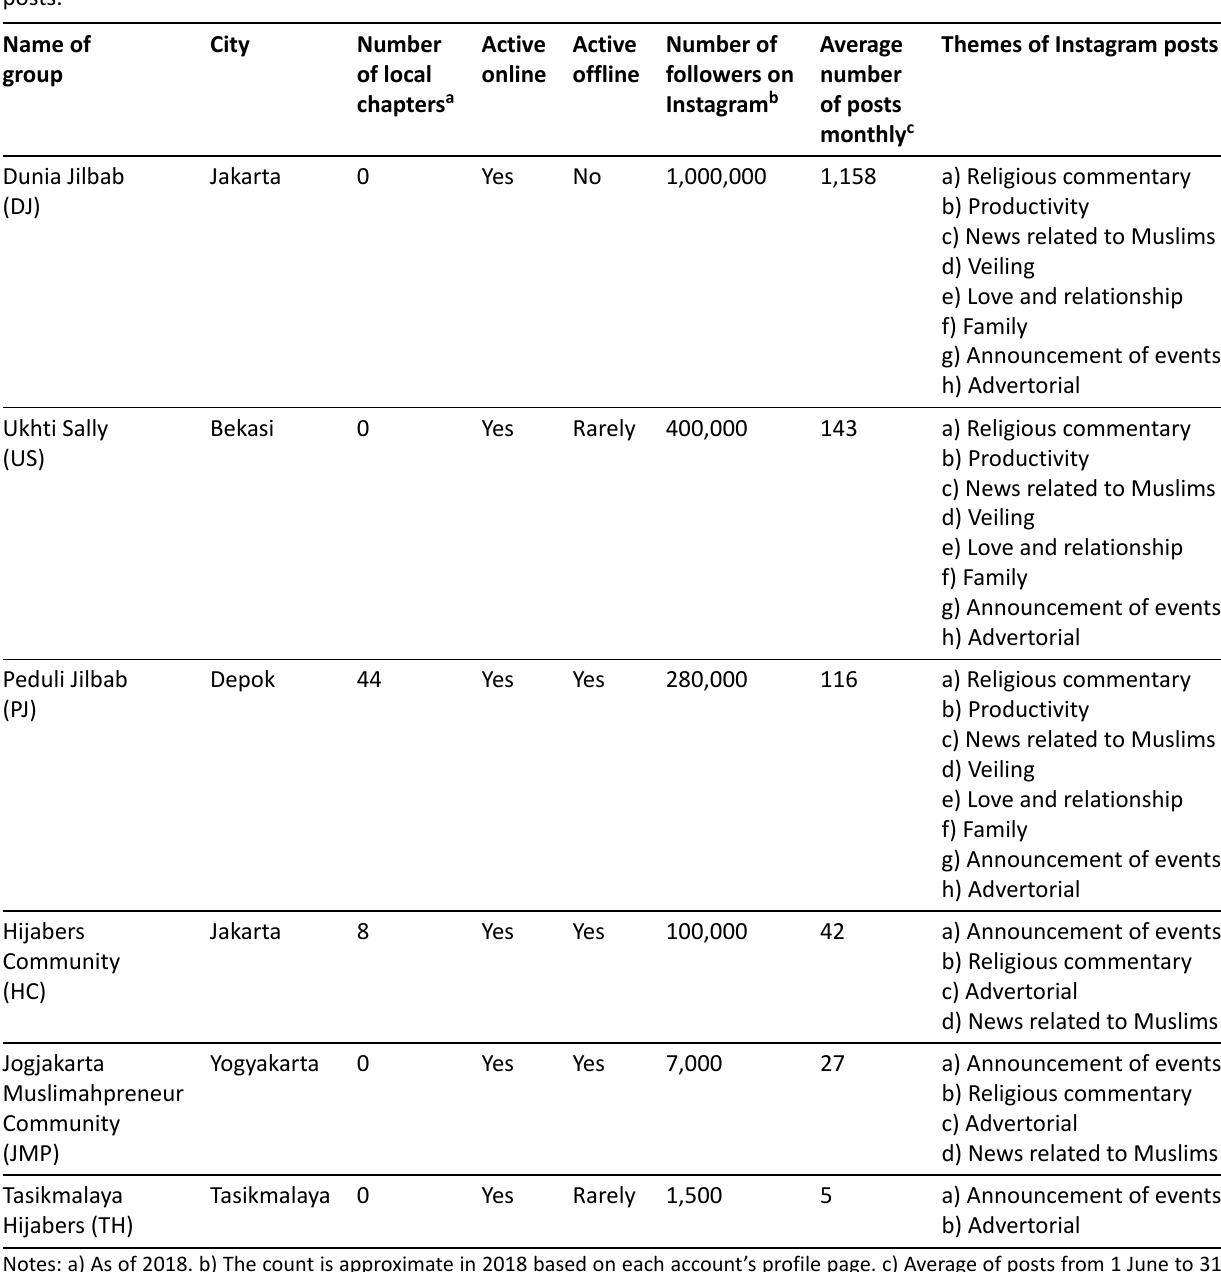
Table 2. Lists the young Muslim women’s groups studied, their popularity, and the themes emerging from their Instagram